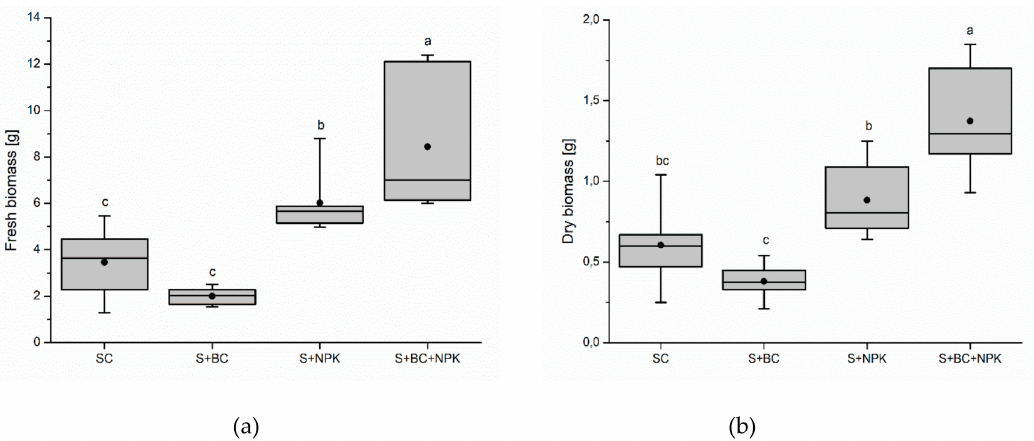
Figure 2. E ff ect of biochar and fertilizer on mean plants biomass (data from third cut): ( a ) fresh biomass and ( b ) dry biomass. Dots indicate mean values, horizontal lines in boxes indicate median. Letters indicate significant di ff erences among the treatments ( p = 0.05).